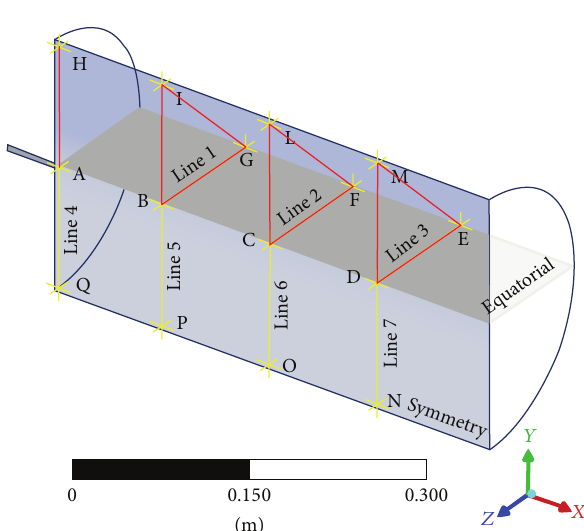
Figure 25: Division of the half tank into four